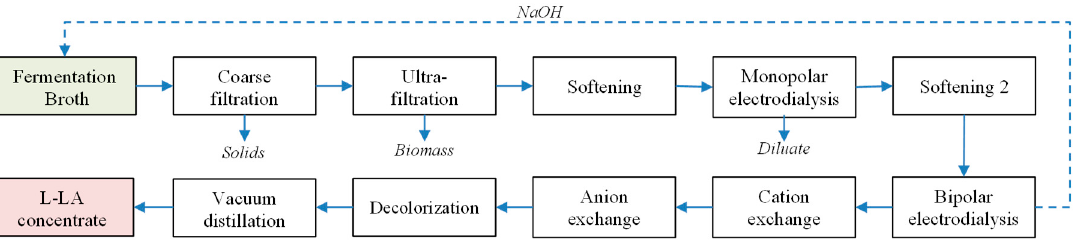
Figure 1. Schematic diagram of the downstream process of lactic acid.